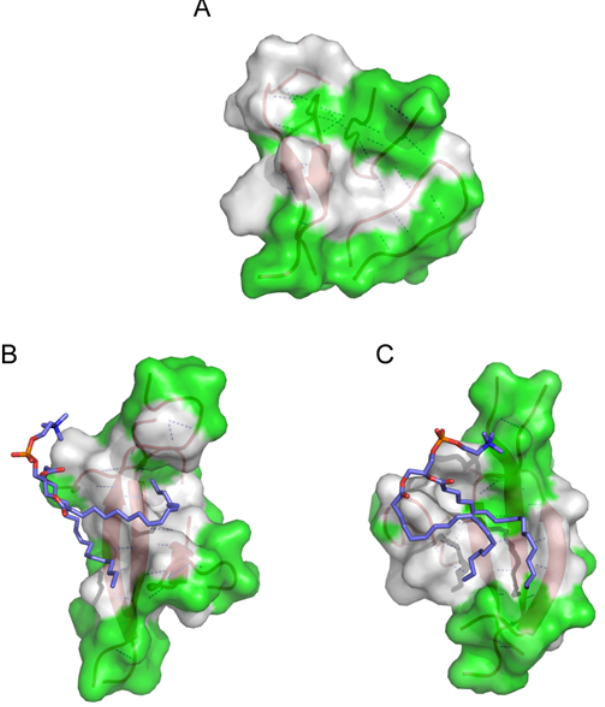
Figure 10. Structural models of lipid- peptide oligomer interaction. (A) One snapshot from hIAPP having 14 b -bridges, (B) and (C) two snapshots from hIAPP/lipid with 16 b -bridges. Peptides are shown in cartoon, red and dashed lines indicate the backbone hydrogen bonds. White color indicates hydrophobic surface (residues F23, A25, I26, L27), green color indicates polar surface. In structures (B) and (C), tails of lipid molecule (in stick, blue) bind to the hydrophobic